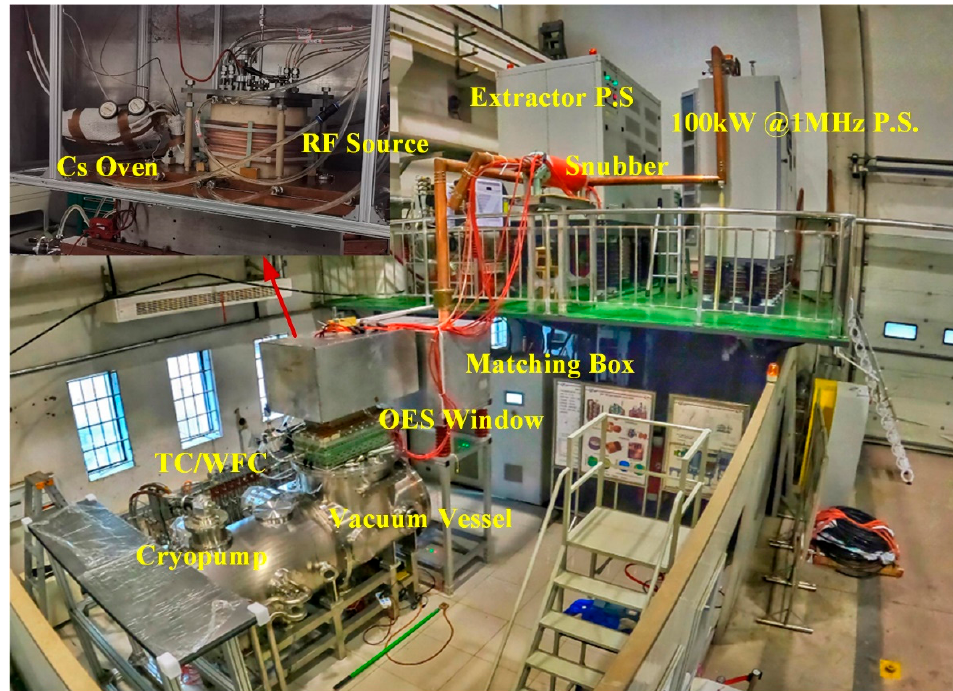
Figure 1. The picture of the RF beam source test facility.